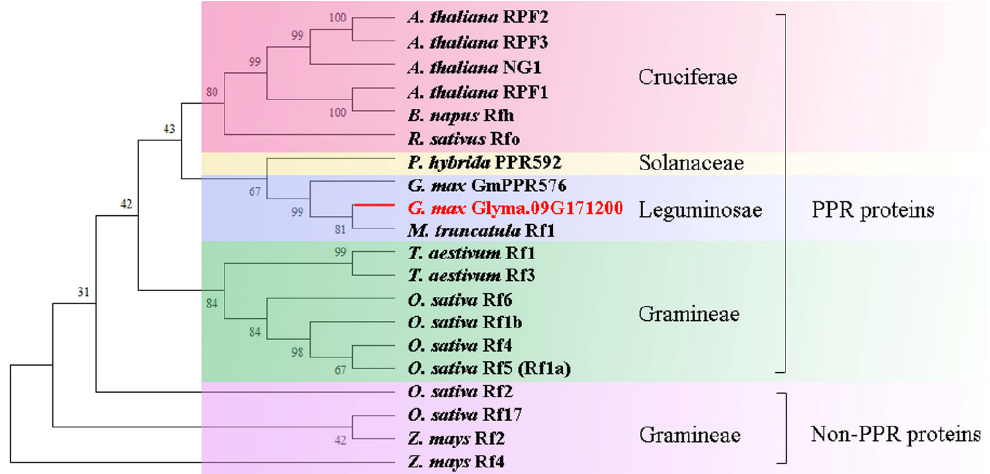
Figure 8. Phylogenetic analysis of Glyma.09G171200. The red branch indicates Glyma.09G171200. Bootstrap values of 1000 were used to assess the robustness of the neighbor-joining tree.